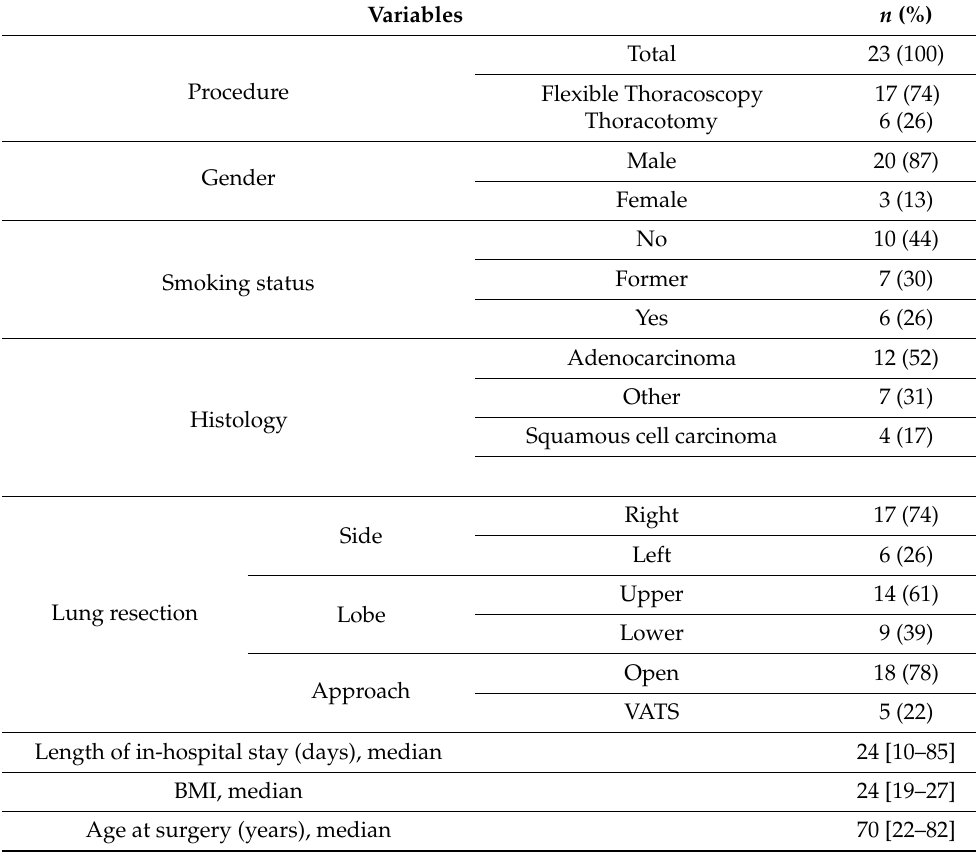
Table 1. Clinicopathological characteristic of patients ( n = sample size, % = percentages, [] = ranges).